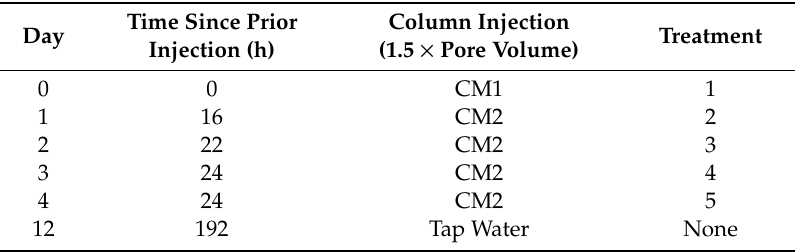
Table 4. Columns treatment